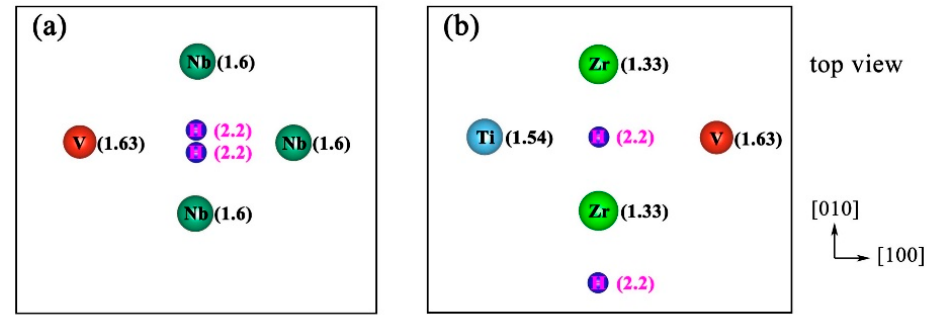
Figure 4. The local distribution of metal atoms around the desorbed hydrogen atoms in ( a ) Configuration 1, ( b ) Configuration 3 for molecular hydrogen desorption. The value in parentheses denotes the electronegativity of the metal atoms. The geometrical structures for Configurations 1 and 3 are presented in Figure 2.